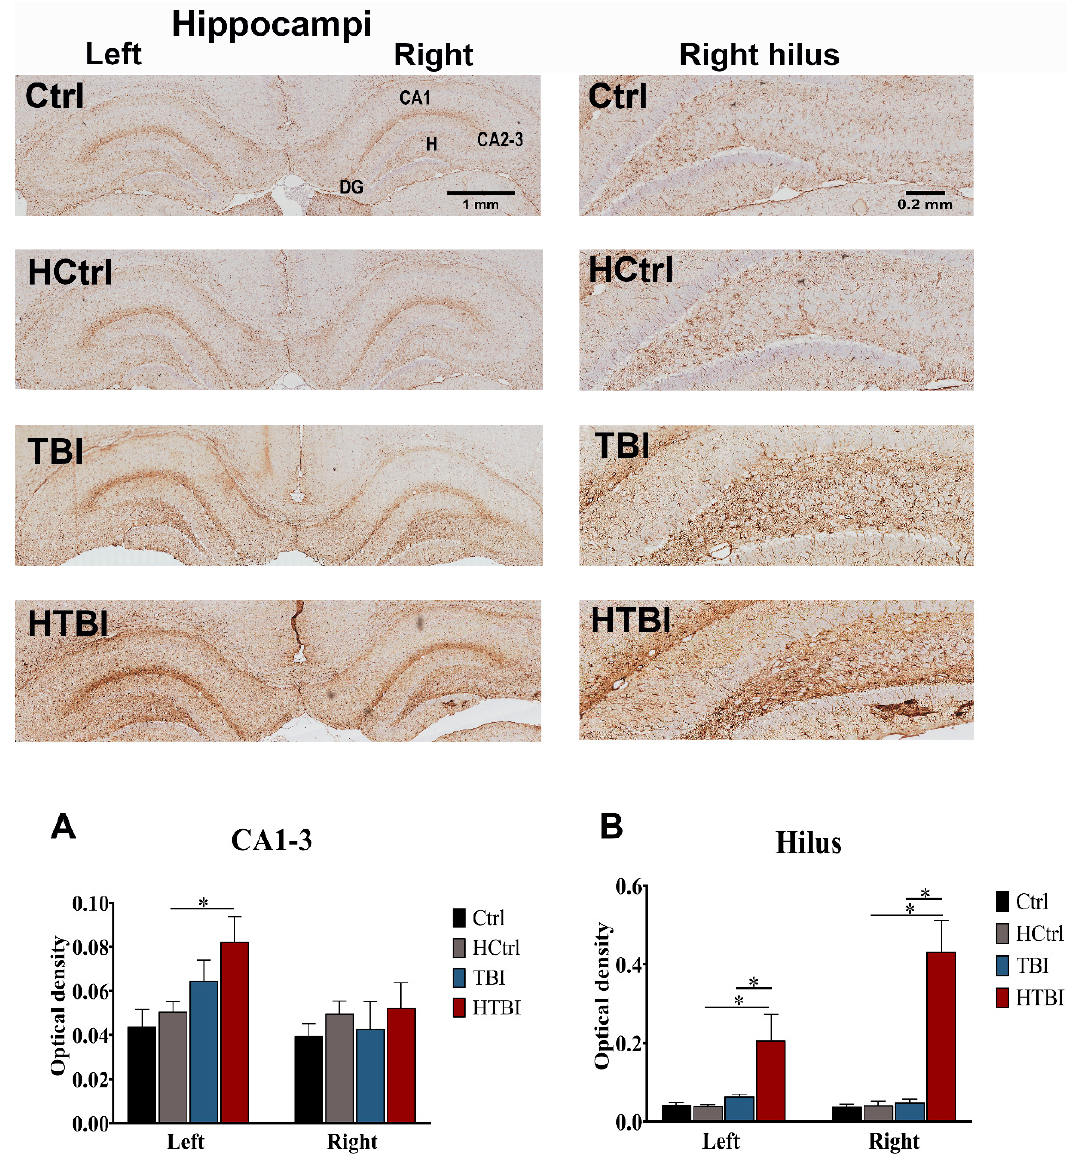
Figure 7. Immunohistochemical assessment of reactive astrogliosis with GFAP (glial fibrillary acidic protein) levels. Shown are illustrative images of coronal hippocampal sections as well as high-power images of the right hippocampal hilar zone ipsilaterally to the impact site. Higher levels of darkly stained astrocytes were observed in the hippocampi of TBI and HTBI rats and more so in the hilar regions bilaterally. In order to quantify this effect, we analyzed the levels of GFAP with optical density measurements on four sections from each brain ( n = 3–5 rats per group). One-way ANOVA with post hoc Fisher’s least significant difference (LSD) revealed a statistically significant increase in CA1-3 optical density in the HTBI group, compared to its control, HCtrl ( p < 0.05), on the left but not the right side ( A ), with no other statistically significant differences in paired comparisons between TBI and HTBI groups or between TBI and its control. Analyses of the hilar regions ( B ) revealed statistically significant higher optical densities in the HTBI group, compared to the TBI group and controls bilaterally ( p < 0.05), while the TBI group had comparable hilar optical densities to controls ( p > 0.05, one-way ANOVA with post hoc Fisher’s LSD). Analyses of the cortical areas revealed no statistically significant differences between groups (left cortex: 0.059 ± 0.002 for Ctrl, 0.072 ± 0.009 for HCtrl, 0.080 ± 0.016 for TBI, 0.066 ± 0.007 for HTBI; right cortex: 0.063 ± 0.003 for Ctrl, 0.063 ± 0.007 for HCtrl, 0.083 ± 0.012 for TBI, 0.066 ± 0.009 for HTBI, p > 0.05, one-way ANOVA with post hoc Fisher’s LSD). Asterisks indicate statistically significant differences ( p < 0.05). Mean ± SEM are represented. (Ctrl: control; D: dentate gyrus, H: hilus; HCtrl: heparinized control; TBI: traumatic brain injury post-saline; HTBI: traumatic brain injury post-heparin).